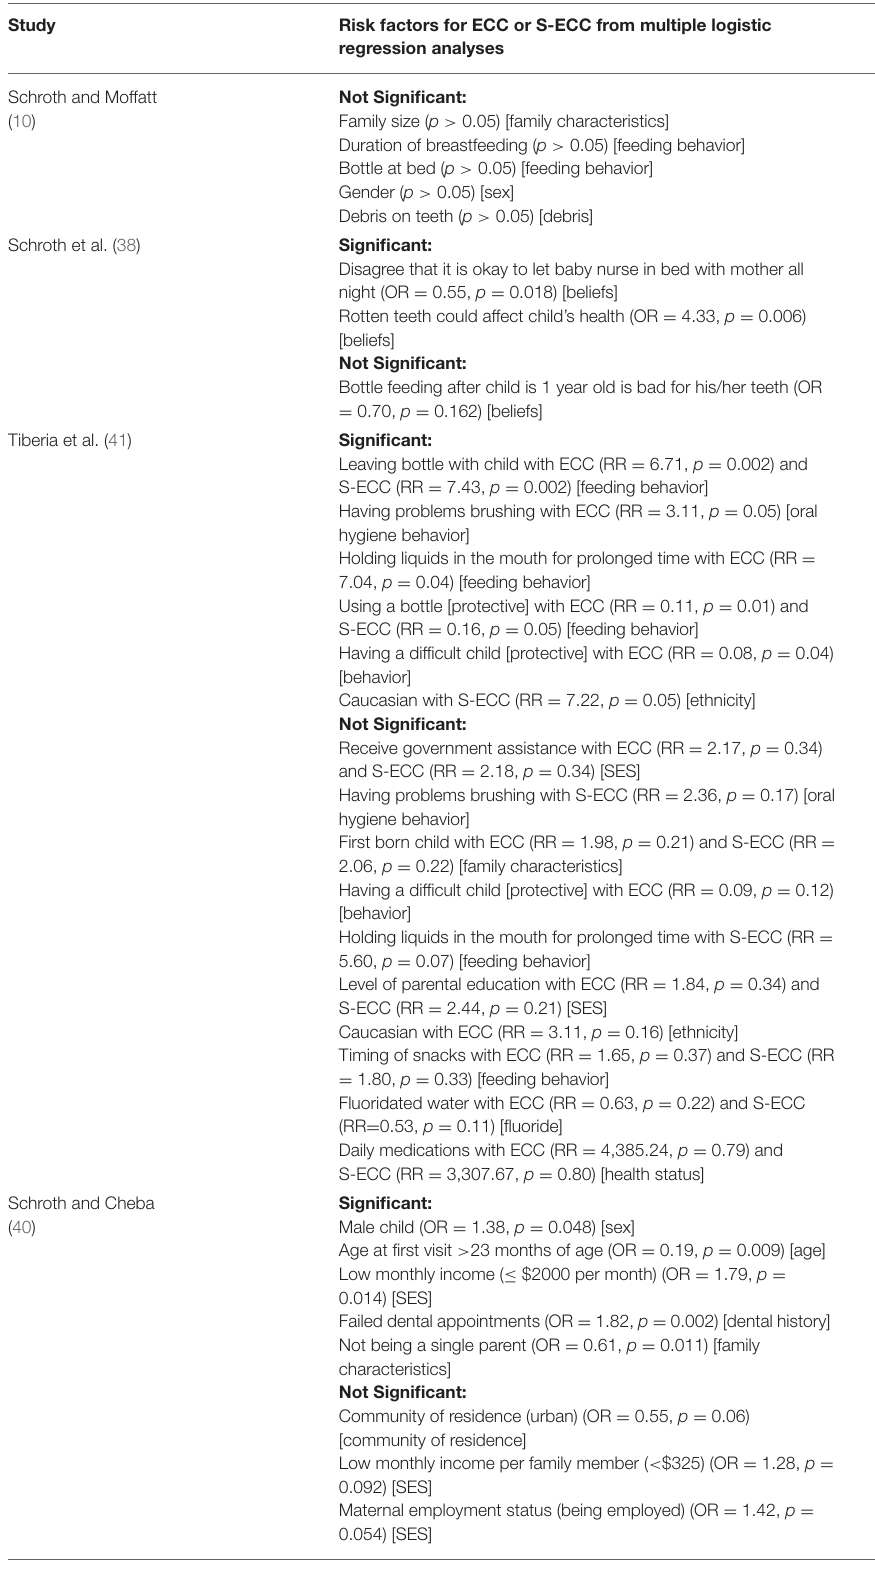
Association with nutrition and well-being